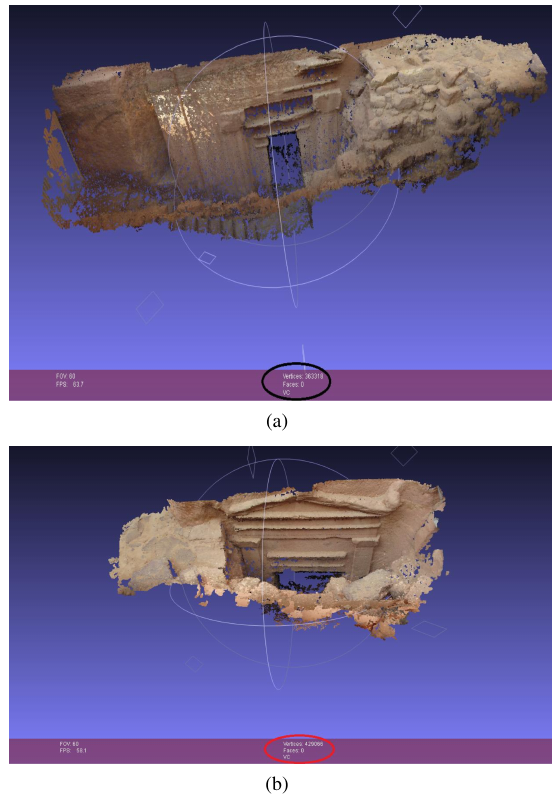
Figure 6. The dense point clouds of the excavation after the com- putation with PMVS-2. (a) and (b) represent respectively the door on the left and the door on the